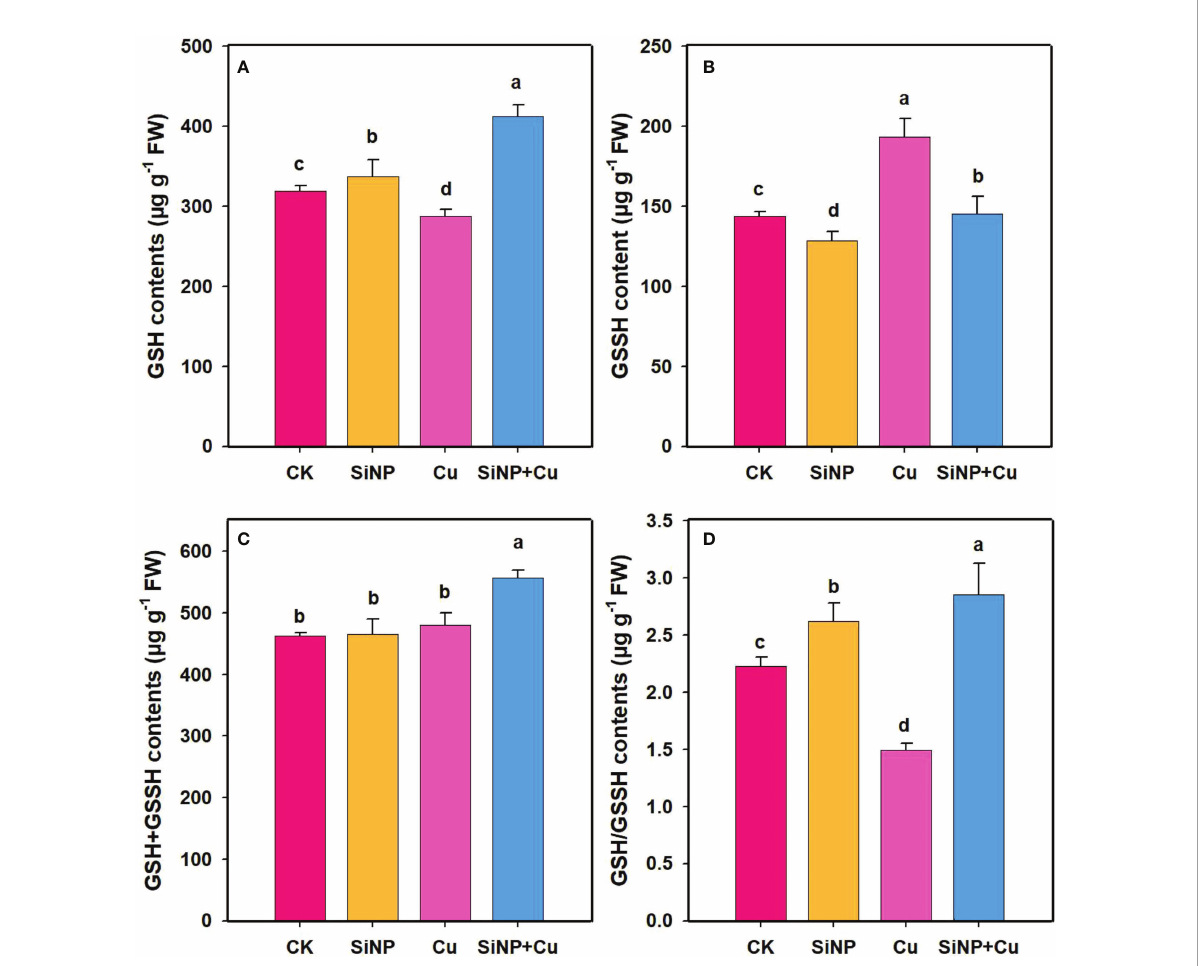
FIGURE 6 GSH contents under Cu 2+ toxicity. Note “ Experimental treatments contained: CK (control); SiNP (2.5 mM SiNPs); Cu (500 µM Cu 2+ alone), SiNP+Cu (2.5 mM SiNPs+500 µM Cu 2+ ). The different letters (a, b, c, d) describe the differences in different treatments by LSD test at (P ≤ 0.05) ” . (A) GSH, (B) GSSH, (C) GSH+GSSH, (D)